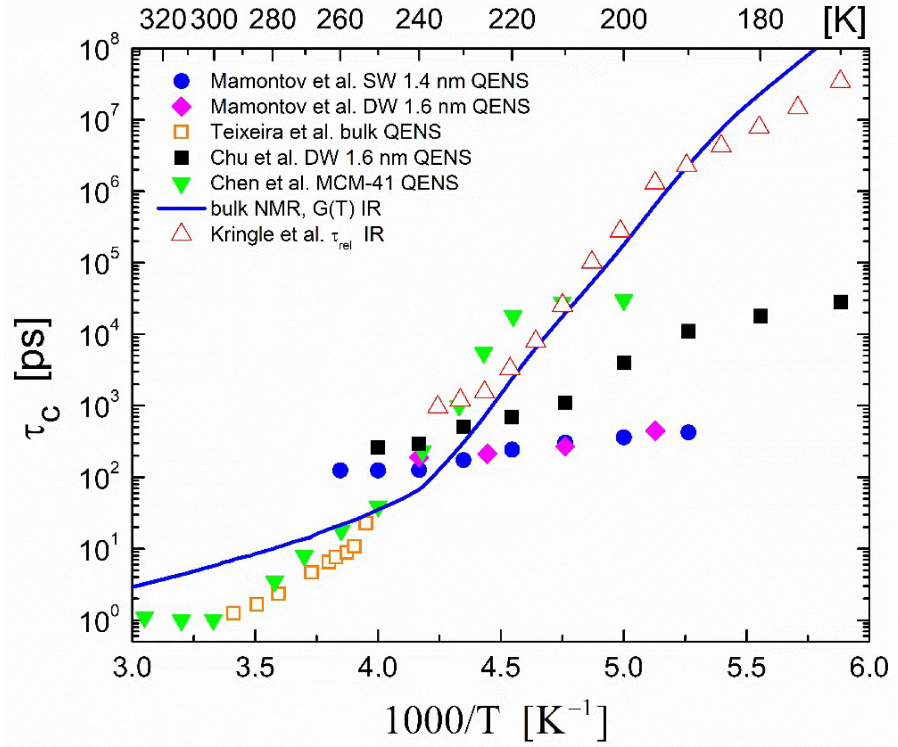
Figure 4. Temperature dependence of the translational correlation times (residence times in QENS experiments) in supercooled confined H 2 O. Filled circles ( • ) and filled diamonds ( (cid:7) ) represent the residence times τ 0 obtained from QENS experiments of H 2 O confined in single-walled (1.4 nm) and double-walled (1.6 nm) carbon nanotubes, respectively (Mamontov et al. [73]). Filled squares ( (cid:4) ) represent the residence times τ 0 obtained from QENS experiments of H 2 O confined in 1.6 nm double-walled carbon nanotubes Chu et al. [93]. Inverted filled triangles ( (cid:72) ) are the residence times obtained from QENS experiments of H 2 O confined in MCM-41-S samples with a 1.8 nm pore diameter (Chen et al. [75]). Orange open squares ( (cid:3) ) represent the residence times τ 0 obtained from QENS experiments of bulk H 2 O (Teixeira et al. [61]). The blue solid line is a guide to the eye for the calculated correlation times obtained from the NMR experiments by Holz et al. [44] and Price et al. [45] and for the growth rate from pulsed heating experiments by Xu et al. [46]. Upright triangles ( ∆ ) are the structural relaxation data of pulsed heated water monitored via reflection–absorption IR spectroscopy (Kringle et al.